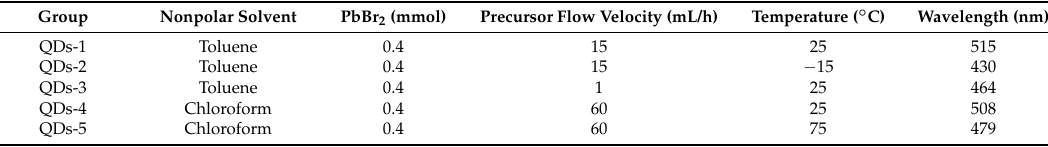
Table A1. Parameters of five groups of QDs-M, nonpolar solvent, dosage of PbBr 2 , precursor flow velocity, temperature, and